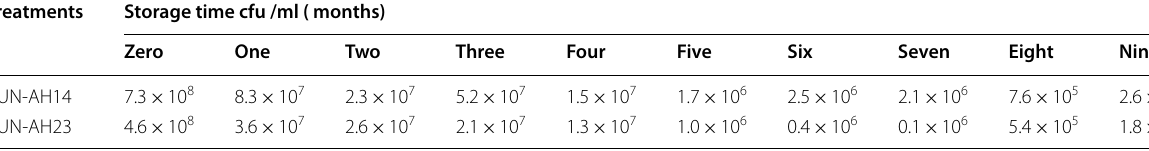
Table 4 Effect of storage period on viability of yeasts formulation Treatments Storage time cfu /ml (